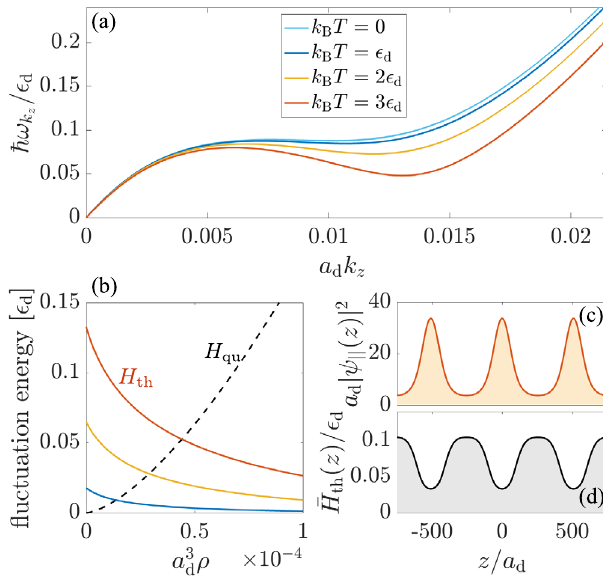
Fig. 2 | Roton softening by thermal fl uctuations. Raising the temperature of a dipolar quantum fl uid can induce a pronounced roton-maxon spectrum of its collectiveexcitations,asshownin a foranin fi nitelyelongatedcondensatealongthe z -axis[seeFig.1c].Heatingthe fl uidtendstolowertheenergyoftherotonminimum andeventuallysoftenstherotonexcitationasthetemperatureincreases.Thiseffect can be traced back to the density dependence of the energy correction caused by fl uctuations, shown in b . While quantum fl uctuations yield an energy H line) that increases with a rising condensate density ρ = ∣ ψ ∣ 2 , the contribution H th from thermal fl uctuations decreases (solid lines). The thermal energy correction H th ( r ), therefore, acts as a focusing nonlinearity that supports the formation of regular density modulations. This is illustrated in c , d , where we show the axial density ρ ∣∣ ( z )= ∫ d x d y ρ ( r ) along with the axial potential (cid:2) H th = ρ (cid:2) 1 ∣∣ respectively. The calculations are performed for a / a d =0.7 and μ = ε d .